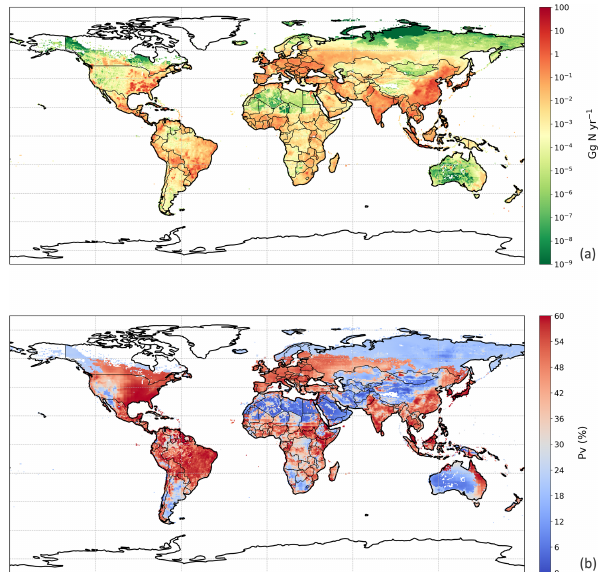
Figure 13. Simulations for chicken housing, manure applications to crops and land spreading of backyard chicken manure in 2010, given in regions. (a) Annual global NH 3 emissions (TgNyr − 1 ). (b) Percentage of excreted nitrogen that volatilizes ( P V ) as NH 3